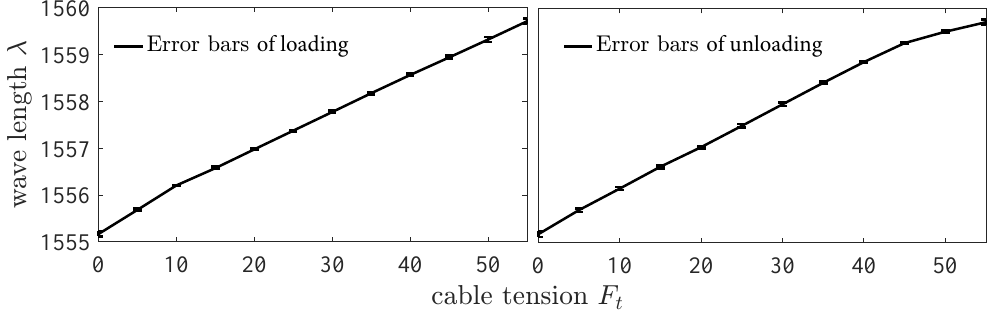
Figure 12. The error bars of wavelength λ changes with the cable tension F t in the direction of increasing input. The error bars represent standard deviation with 5